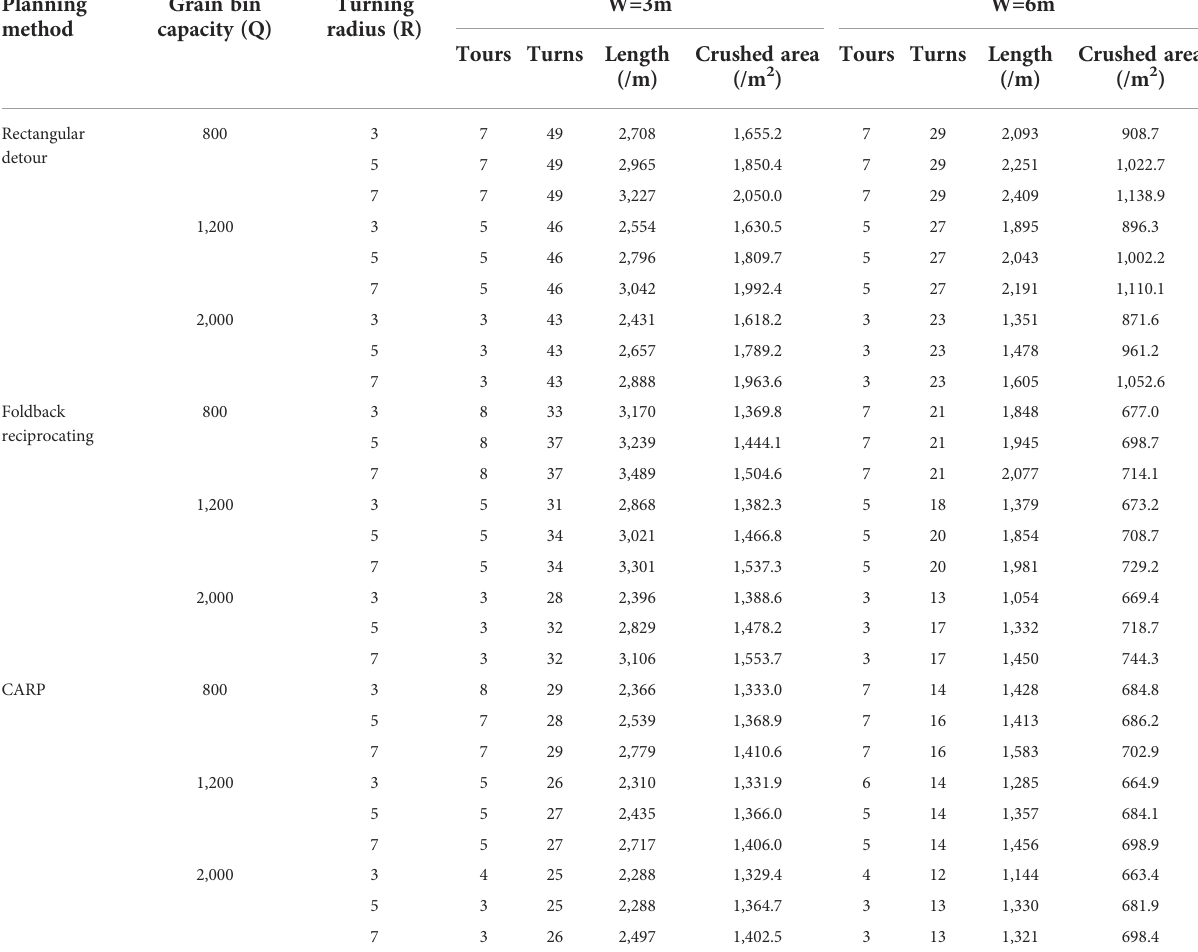
TABLE 8 Effect of different machine parameters on path planning results. Planning method